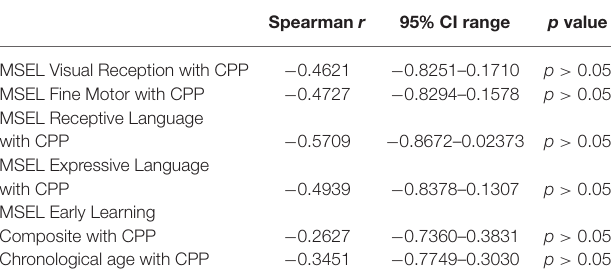
TABLE 2 | Spearman’s rank-order correlations for MSEL sub-scales and chronological age with CPP